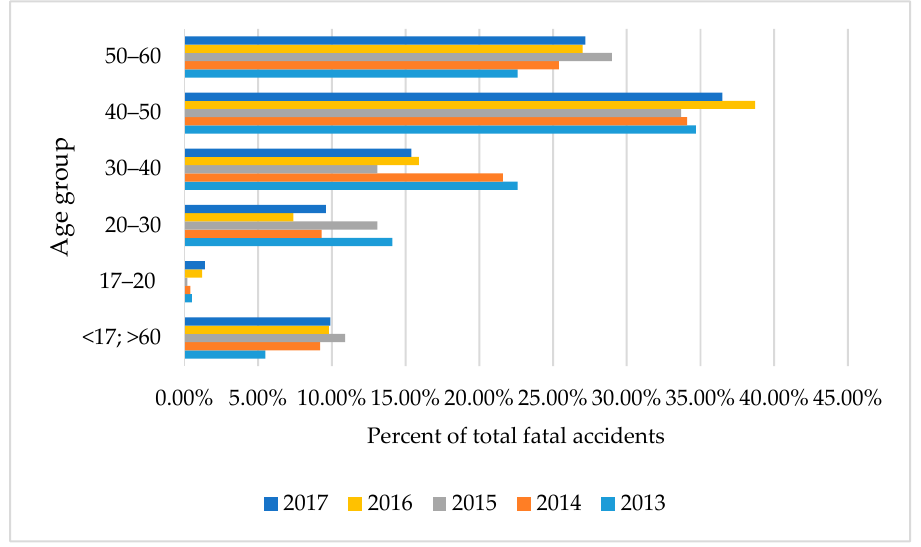
Figure 15. Assessing fatal work accidents by age group [1,2].